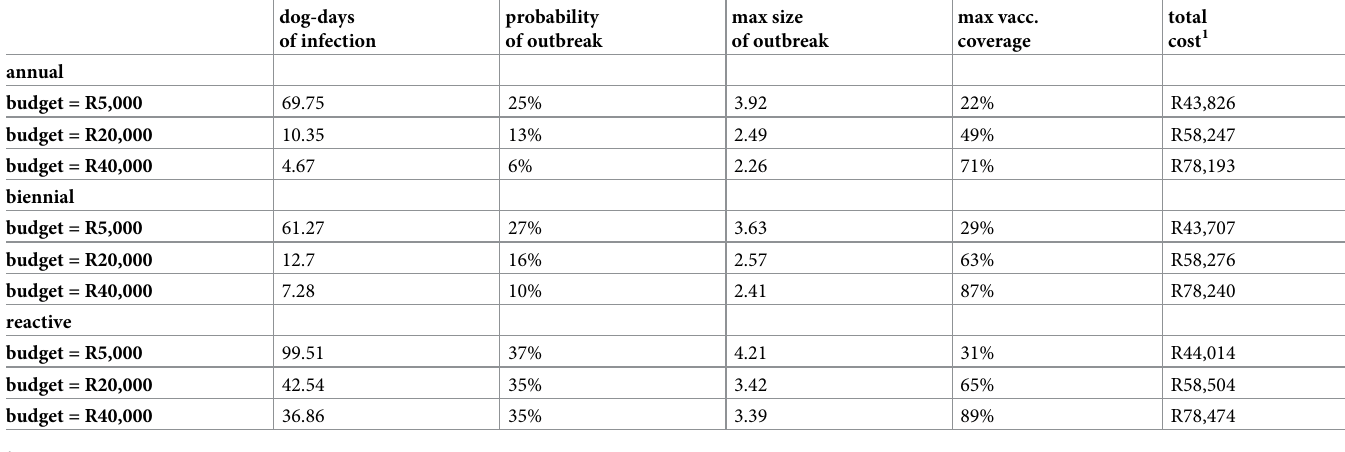
Table 4. Puppy vaccination (also included adult and juvenile vaccination) results. dog-days of